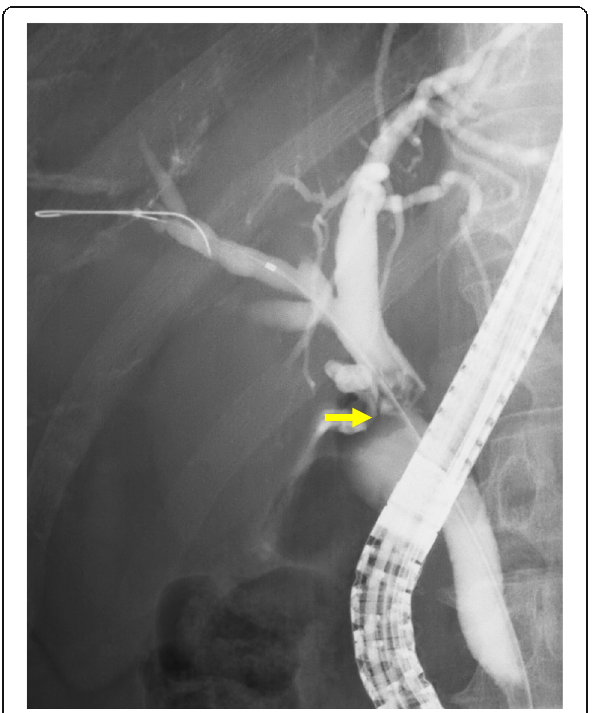
Fig. 2 Endoscopic retrograde cholangiopancreatography revealed stenosis of the distal bile duct. Examination of a biopsy specimen from the distal bile duct wall revealed adenocarcinoma